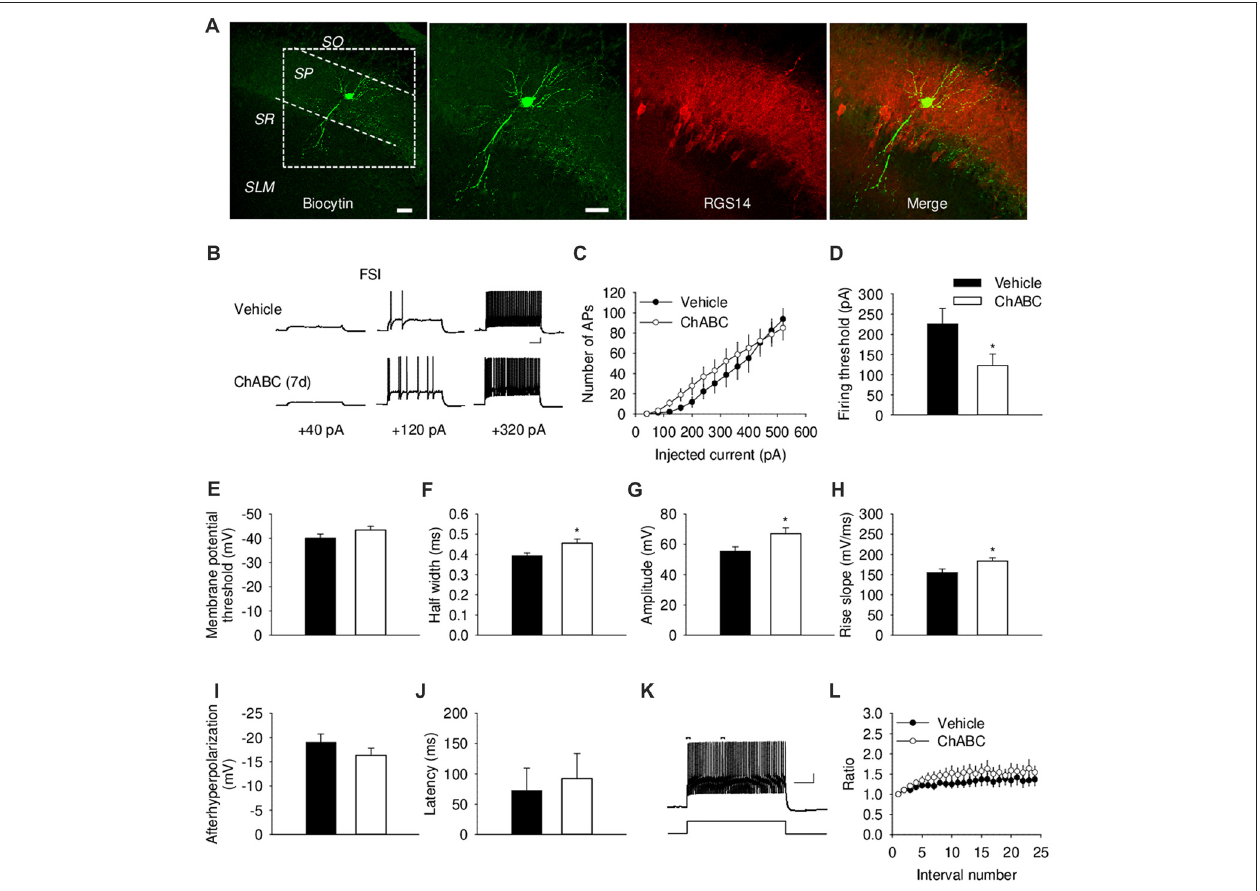
FIGURE 3 | Basic electrical properties of CA2 fast-spiking interneurons (FSIs) 7 days (7 d) after intrahippocampal injection of ChABC. (A) Intracellular staining of the recorded CA2 FSI. Scale bar, 50 µ m. (B) Sample traces of action potentials in the CA2 FSI. Scale bars, 10 mV/100 ms. (C) Number of action potentials elicited in CA2 FSIs in response to multiple steps of depolarizing current. Two-way RM ANOVA, effects of ChABC: P > 0.05. Bar graphs comparing ChABC- ( n = 11) vs. vehicle-treated ( n = 12) FSIs in terms of the firing threshold (D) , the threshold depolarization necessary for action potential generation (E) , the half-width of action potentials (F) , the amplitude of action potentials (G) , the rise slope of action potentials (H) , the afterhyperpolarization of action potentials (I) , the action potential latency of PCs (J) . Bars represent mean ± SEM. ∗ P < 0.05, unpaired t -test/U-test, compared with vehicle. (K) An example of action potential adaptation. Scale bars, 10 mV/100 ms. Upper bars indicating the first and last intervals used to calculate action potential adaptation. (L) Action potential adaptation, measured as a ratio of the intervals between the first two and pairs of following action potentials generated at 480 pA current